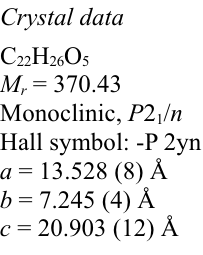
Showing hydrogen bonded molecules through O—H···O. 4-(4-Octyloxybenzoyloxy)benzoic acid Crystal